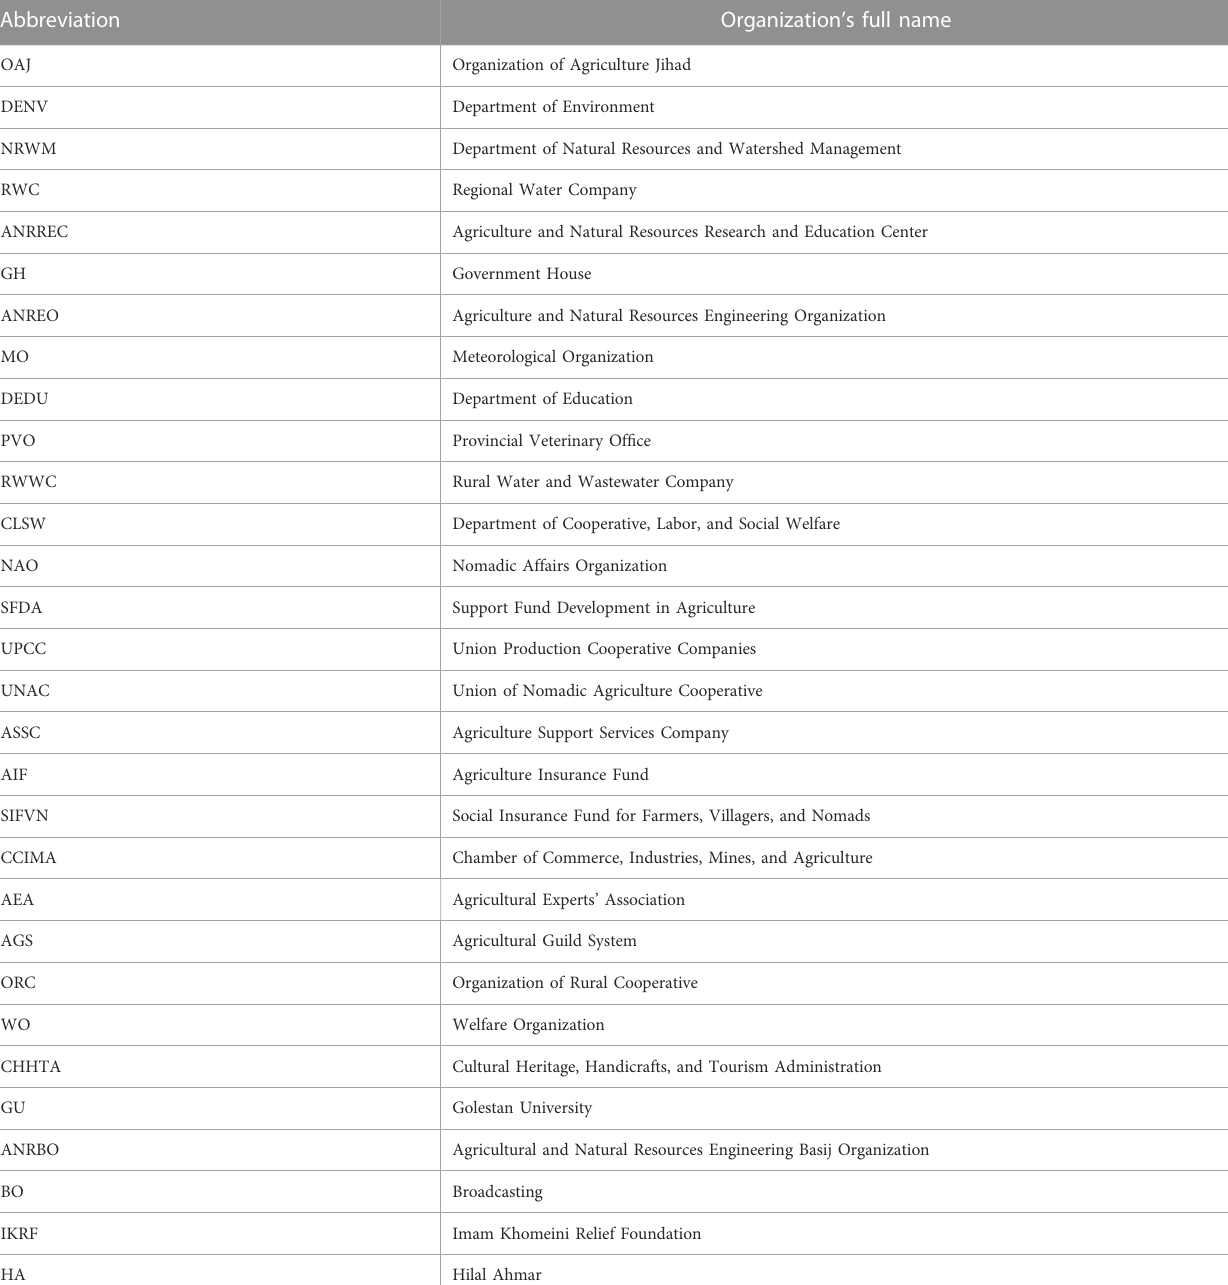
TABLE 2 Full names and abbreviations of the organizations involved in the Chehelchay